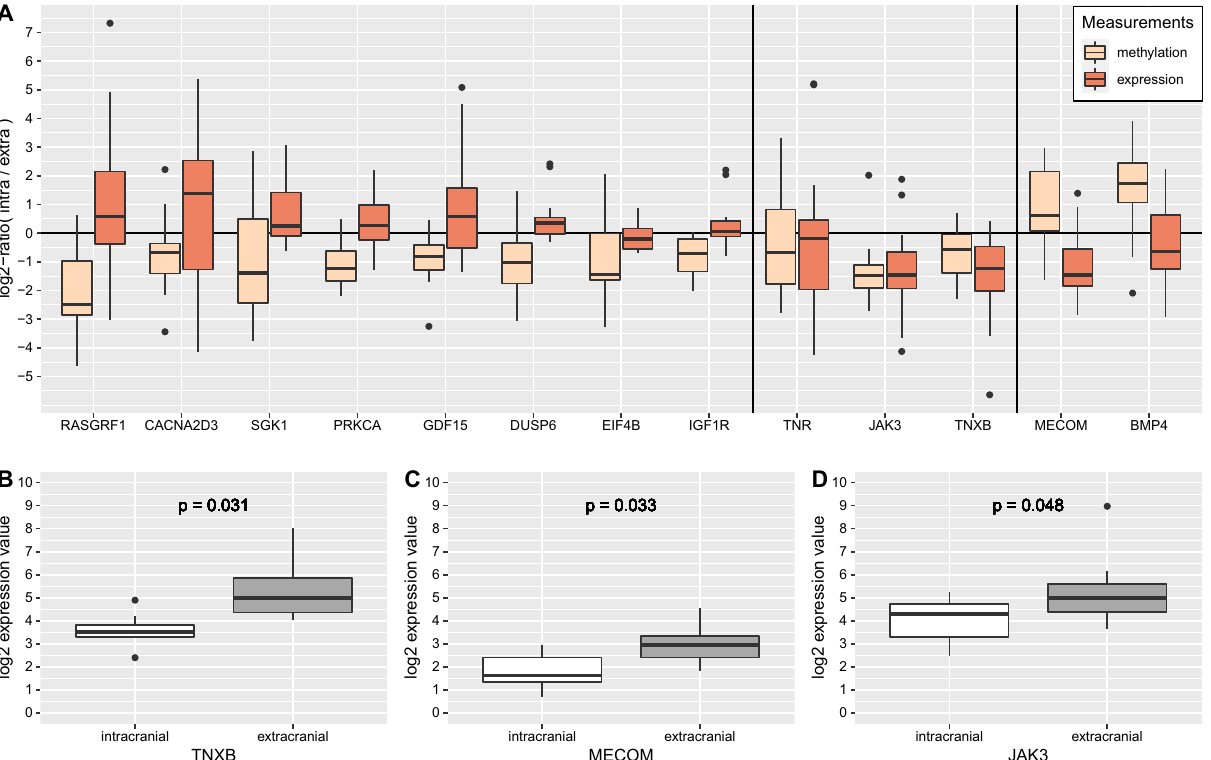
Figure 7. Expression behavior of selected signaling pathway gene candidates with altered gene body methylation that best distinguish intra- and extracranial melanoma metastases based on methylation data. ( A ) Boxplots representing gene body methylation differences (light brown) and gene expression differences (red) based on log 2 -ratios comparing gene-specific measurements of intra- to extracranial metastases considering available data of eight patients. Gene names are shown below the boxplot pairs. Two vertical black lines were inserted into the plot to enable a better visual separation of the genes into three classes that differ in their methylation and expression behavior of the assigned genes. ( B – D ) Boxplots of intra- and extracranial expression levels of the three genes with the greatest expression difference from zero in subpanel ( A ). The three genes were selected at the FDR-adjusted p value cutoff of 0.05. P values were obtained by paired t-tests comparing gene- specific expression levels of the patient-matched intra- and extracranial metastases